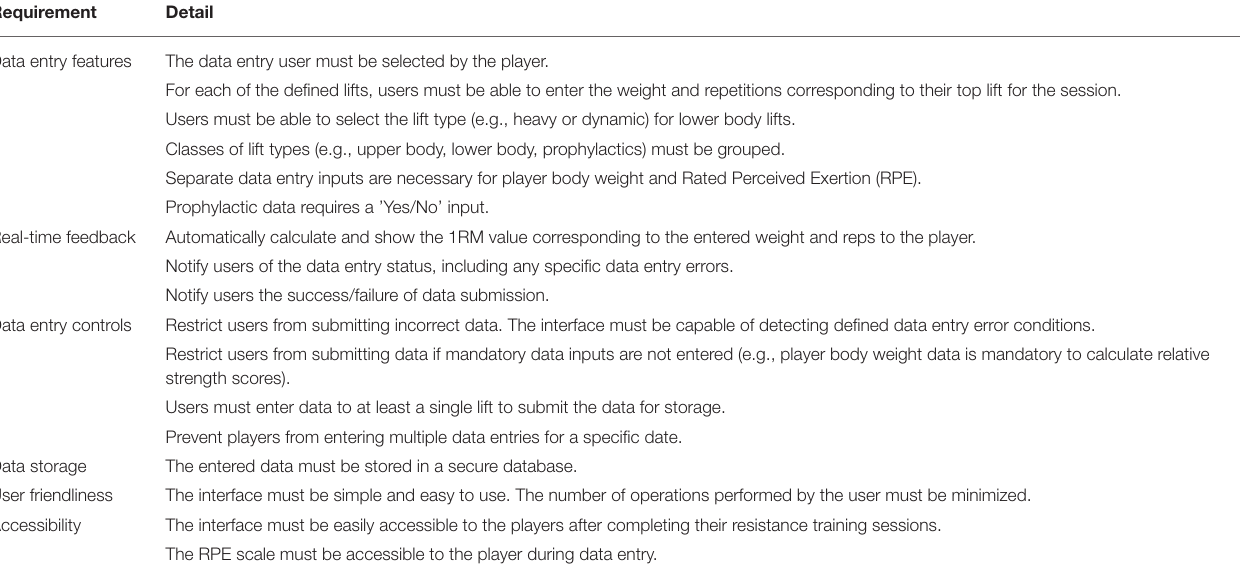
TABLE 3 | User defined functionality requirements of the resistance training data collection